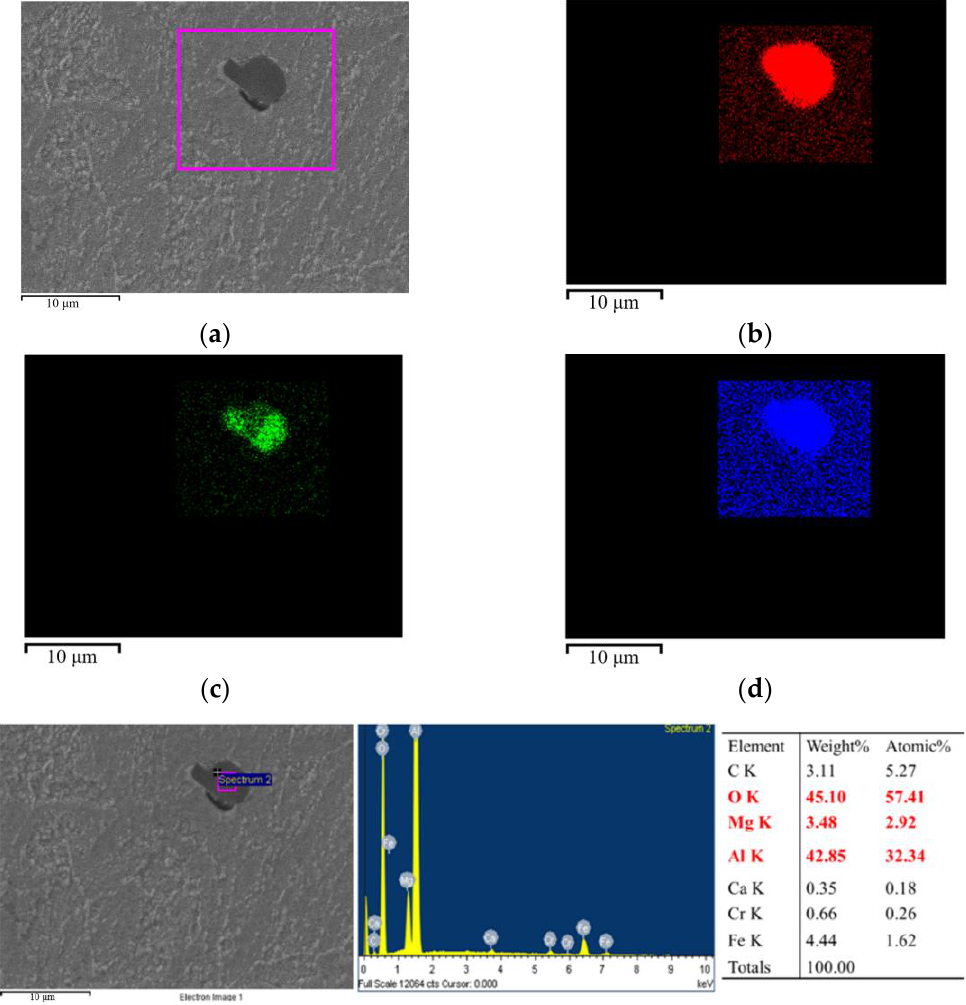
Figure 5. EDS results of typical Al 2 O 3 -MgO complex inclusion in experimental P91 steel; ( a ) SEM image; ( b ) Al mapping; ( c ) Mg mapping; ( d ) O mapping; ( e ) Results of EDS point scanning.